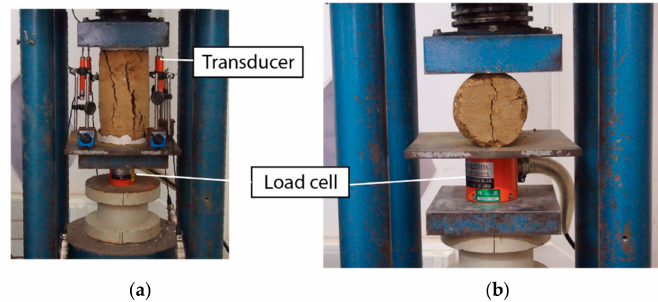
Figure 4. Material characterization test: ( a ) Compressive test; ( b ) Tensile splitting